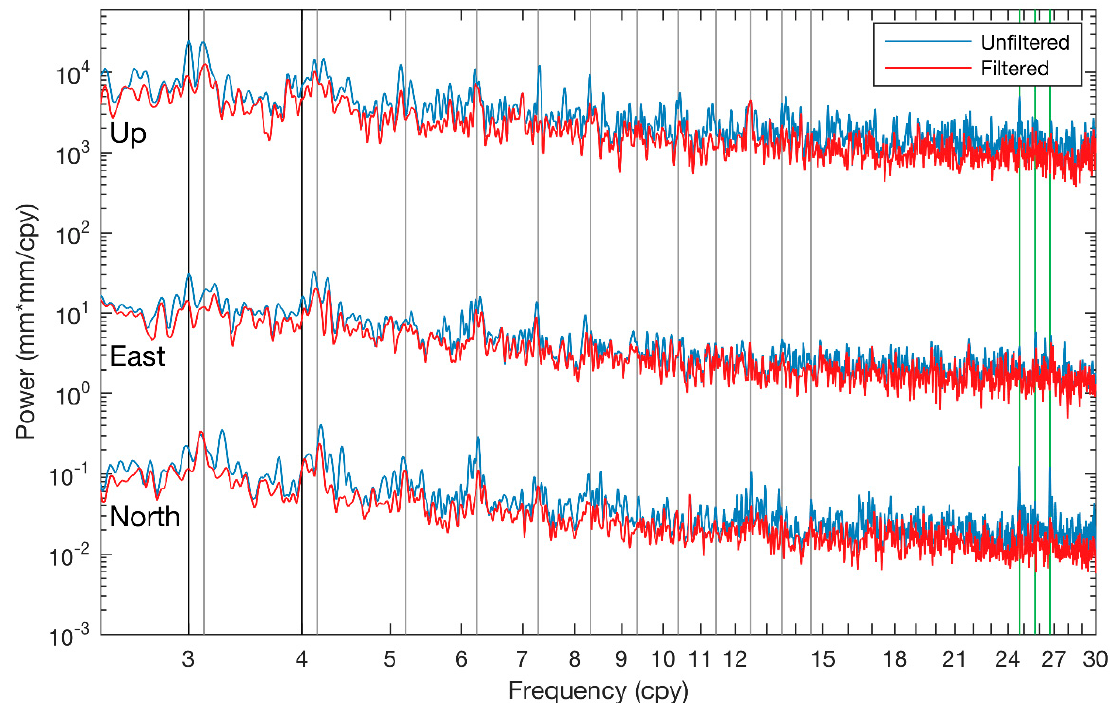
Figure 8. A zoom-in of Figure 7. Vertical dashed gray lines indicate harmonics of the draconitic oscillations (1.04 cpy) up to the 14th.